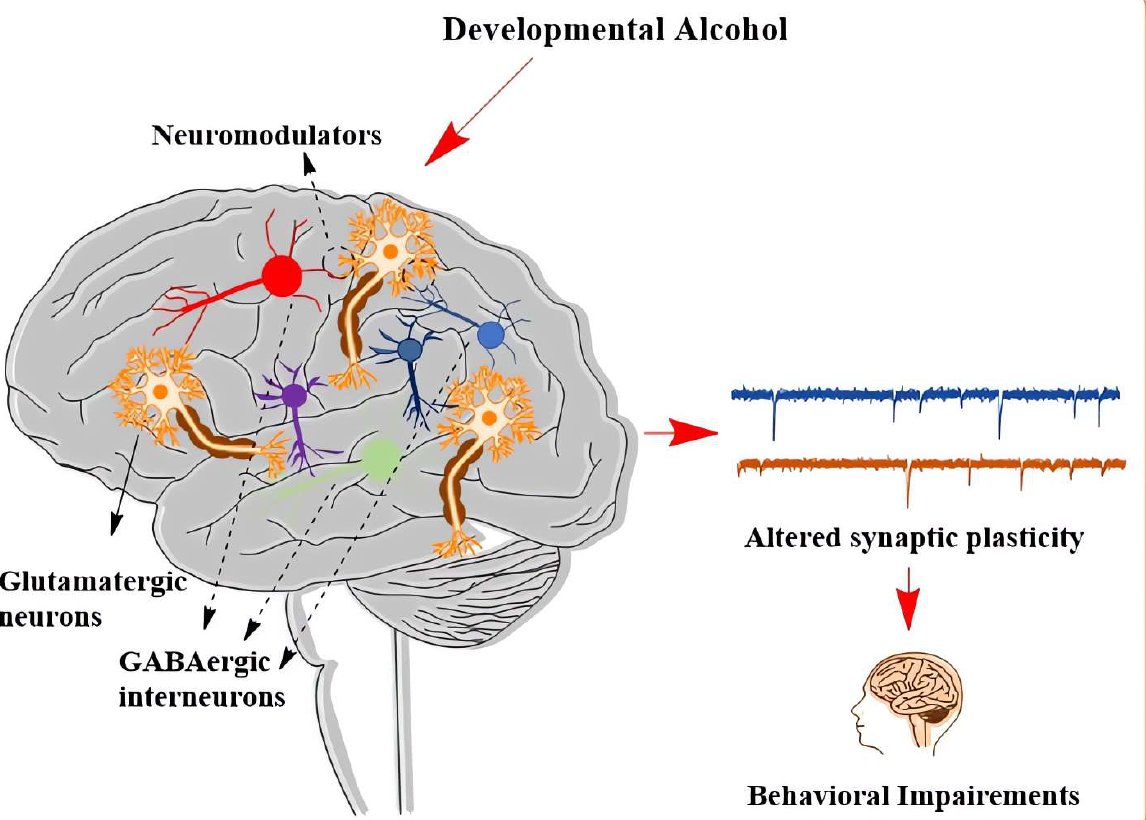
Figure 3. Alterations in glutamatergic and GABAergic neurons and their modulators were found in FASD models. Developmental alcohol exposure causes persistent changes in glutamatergic and GABAergic neuron function, causing synaptic plasticity defects that result in many psychiatric disorders found in FASD, including cognitive and social interaction behavioral impairments.